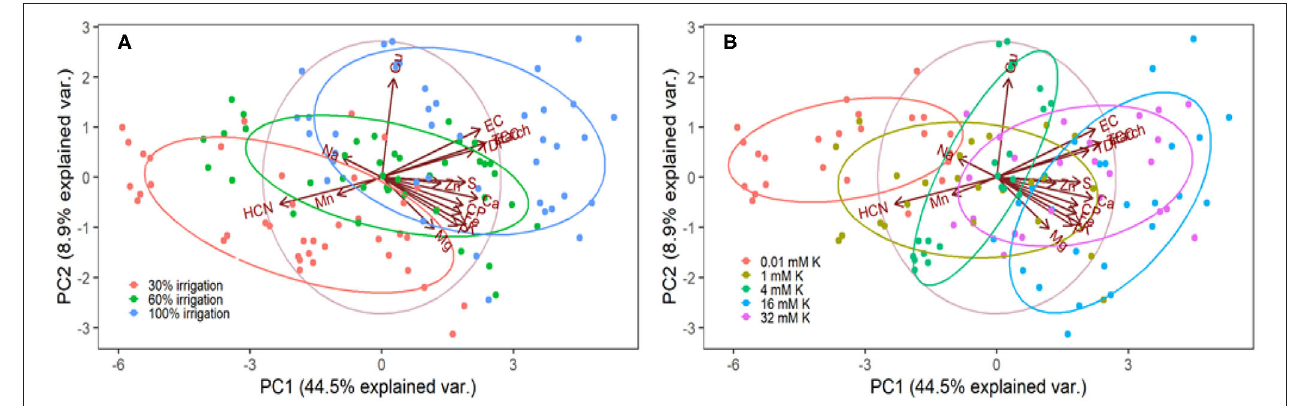
FIGURE 3 | Biplot of the first two components of the Principal Component Analysis of combined nutrient content in leaves and roots of young cassava plants, as affected by irrigation (A) and potassium fertigation (B) .